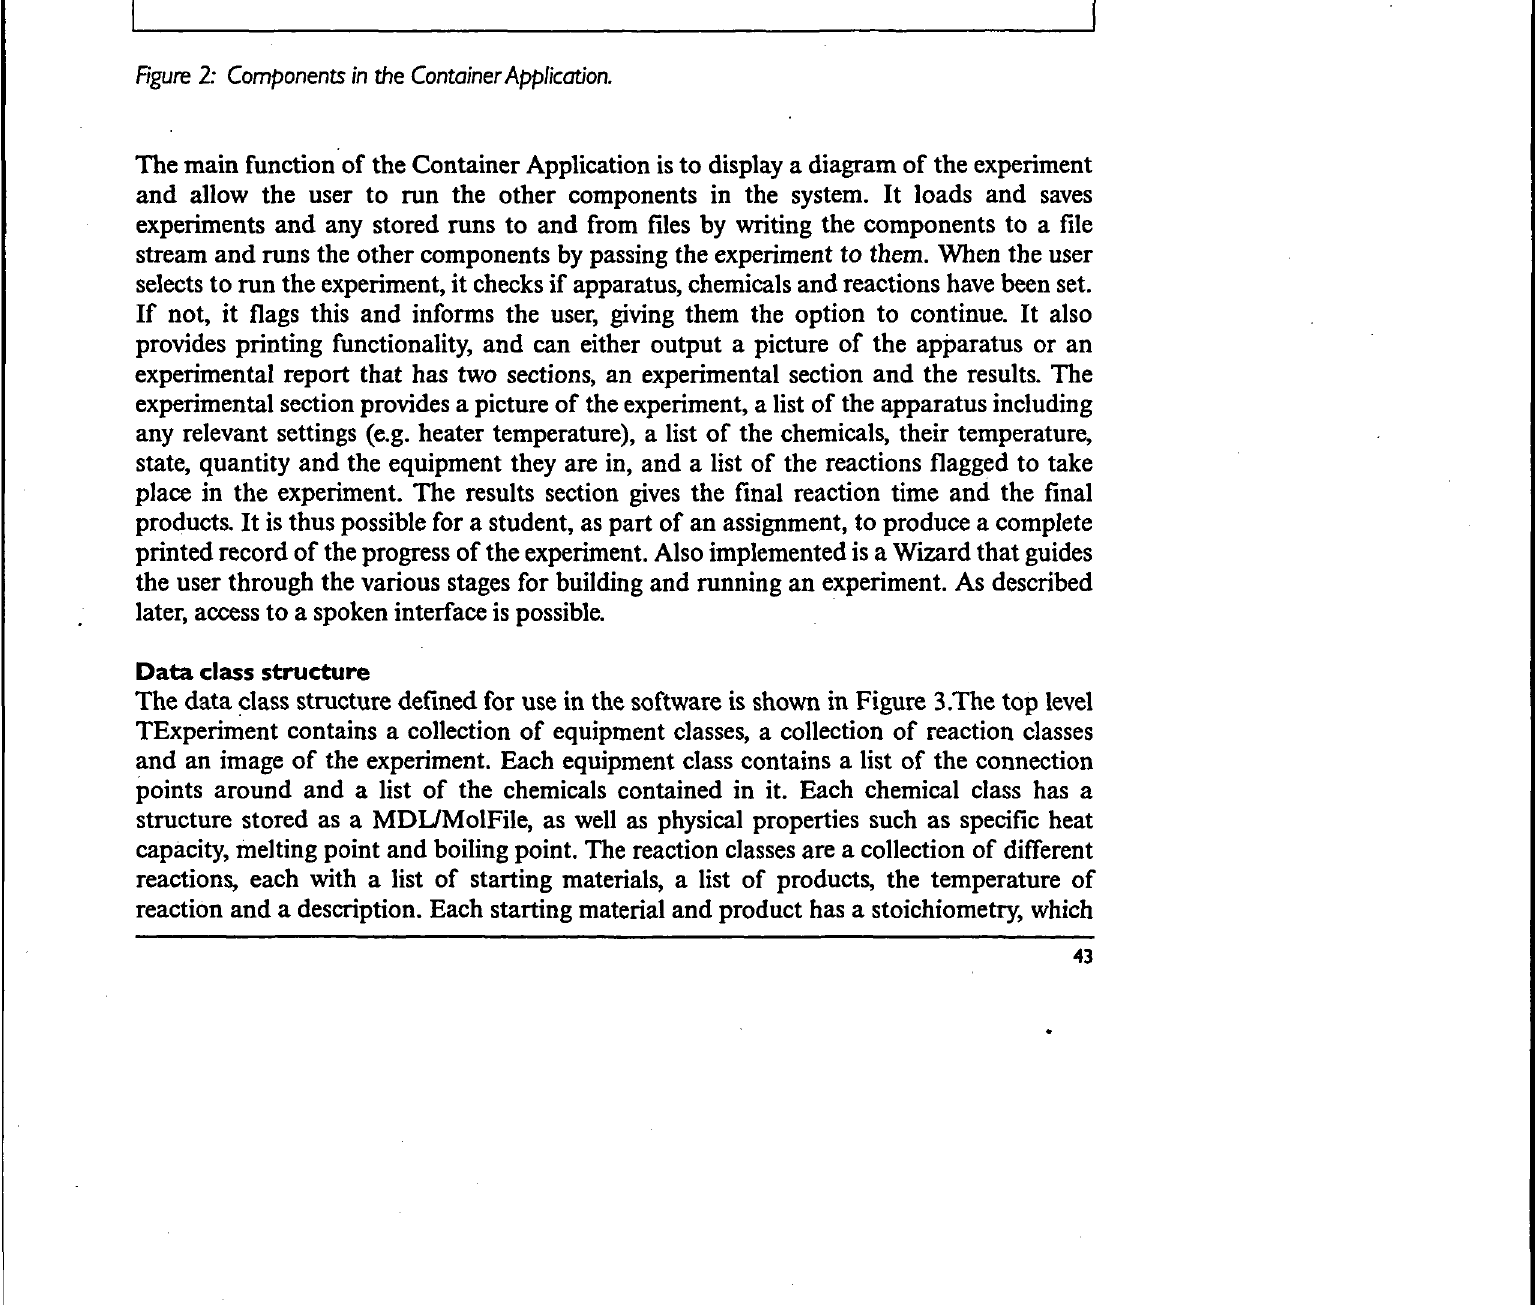
figure /: Object model of the software.